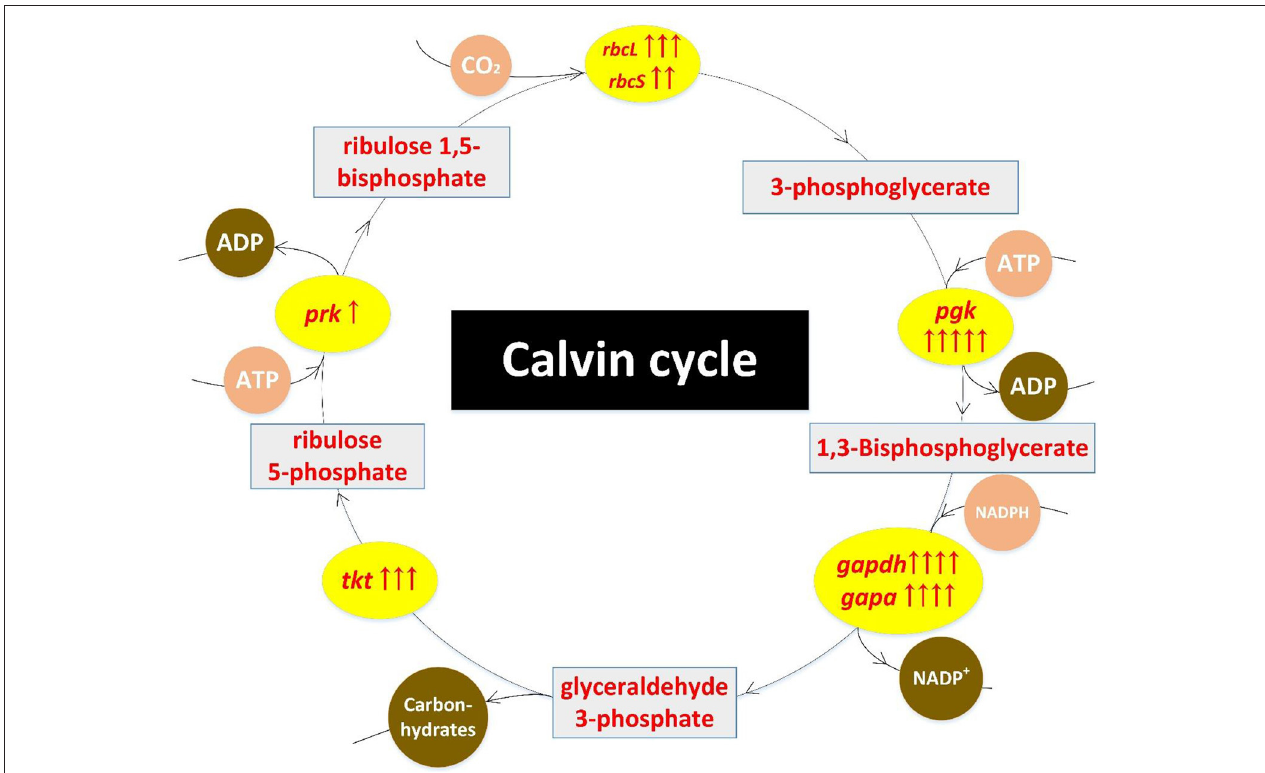
FIGURE 5 | Up-regulation of Calvin cycle-related genes in the Nannochloropsis mutant ZJU700 after nuclear radiation. Yellow ovals represent enhanced enzymes with up-regulated genes. One red upward arrow means that log 2 (fold change of up-regulated gene expression) is higher than 1, two red upward arrows means that log 2 (fold change of up-regulated gene expression) is higher than 2,